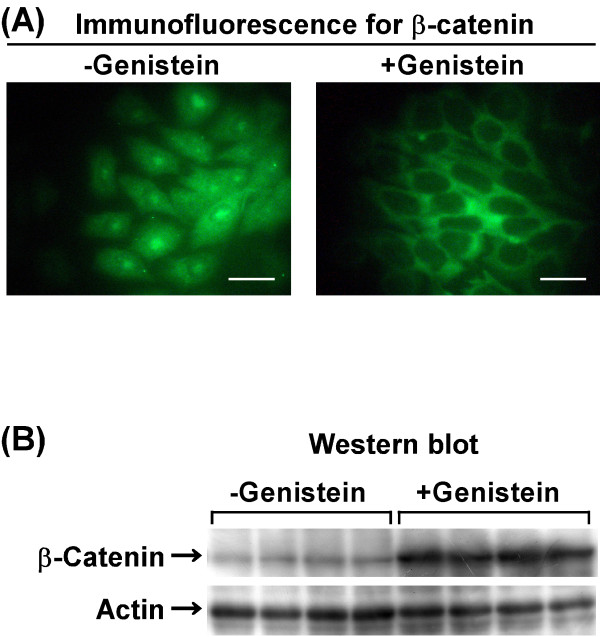
Effect of genistein on subcellular localization and cellularlevel of β-catenin. (A) LM8 cells were treated for 3 days without (left panel) or with (right panel) 50 μM genistein, and immunofluorescence staining of β-catenin was performed. Scale bar: 50 μm. (B) LM8 cells were treated for 3 days without or with 50 μM genistein, and the expression of β-catenin and actin was analyzed by Western blot.